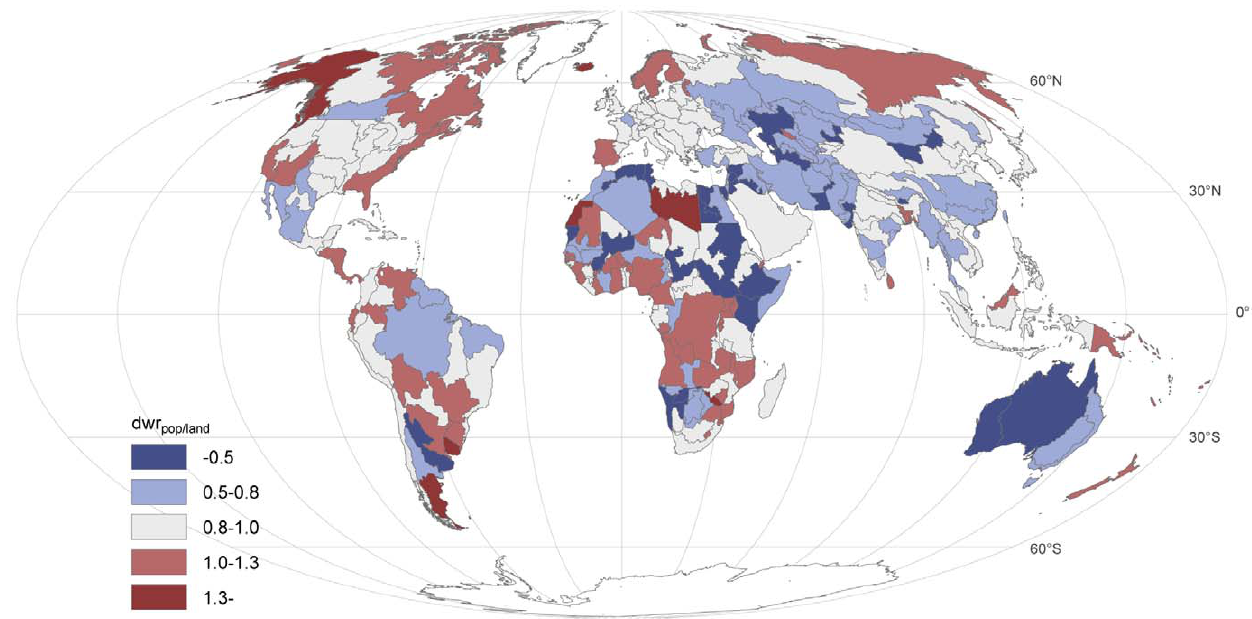
Figure 5. Ratio ( dwr pop/land ) of ‘population distance to water’ ( dw pop ) over the ‘land distance to water’ ( dw land ) by FPUs (for regional results see Table 4; Supporting Information S2). In areas where the ratio is smaller than 1, people live relatively close to water as the average dw pop is lower than the average dw land in that FPU. For areas with a ratio greater than 1, on the other hand, the opposite is the case and people live relatively far from freshwater sources. The thresholds are derived from the statistical analysis as follows: dwr pop / land is between 0.5–1.3 for 95% of the cases, and between 0.8 and 1.0 in 50% of the cases (i.e. the grey values represent FPUs within this 50% interval).